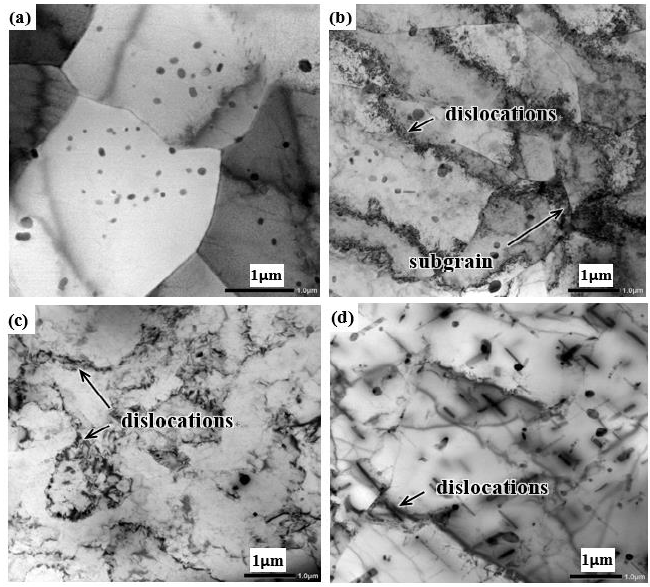
Figure 7. Transmission electron microscope (TEM) bright field of dislocations ( a ) T6; ( b ) 200 °C; ( c ) 300 °C; ( d ) 400 °C under 50% compression.